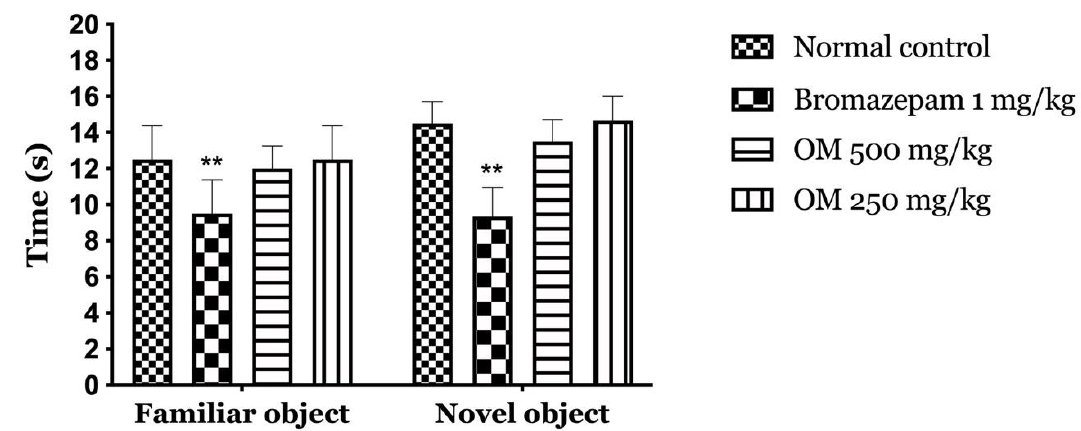
Figure 6. Novel object recognition test effect of OM on the memory object recognition test. Values are expressed as mean ± SEM. The analysis was done using two-way repeated-measures analysis of variance followed by Dunnett post hoc test ** p < 0.01 compared with normal control.